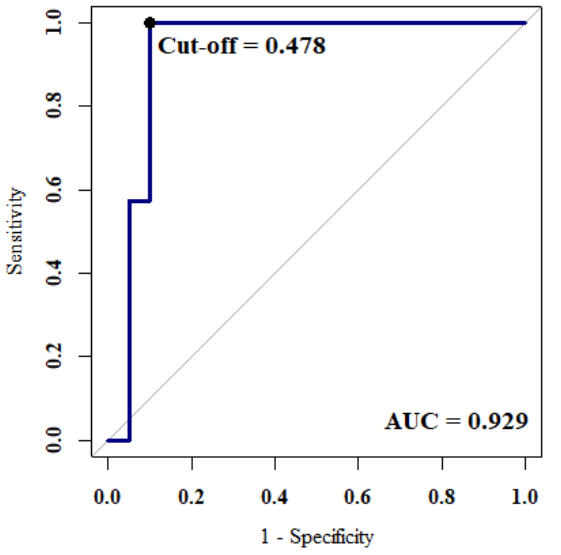
Figure 4. The ROC curve of the best model reached an AUC value of 0.929. The best cut-off value of the proposed regression model was 0.478.